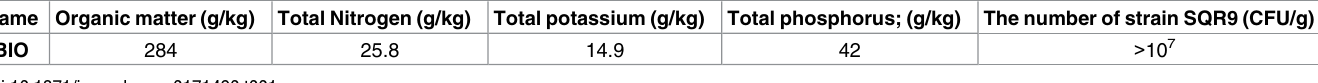
Table 1. The composition of bio-organic